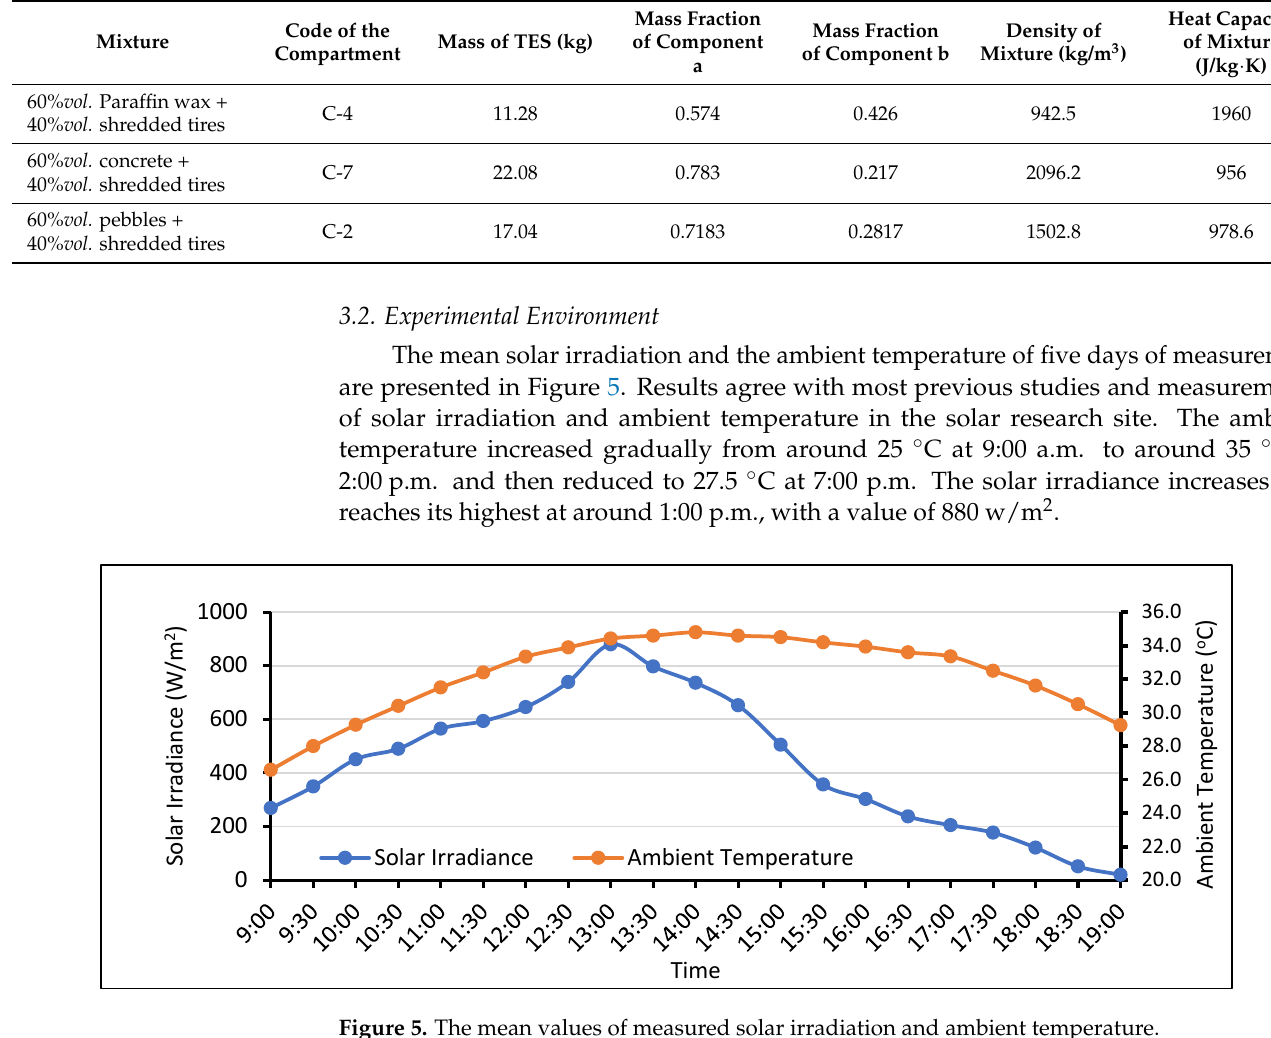
Table 4. Predicted density and heat capacity of mixtures.